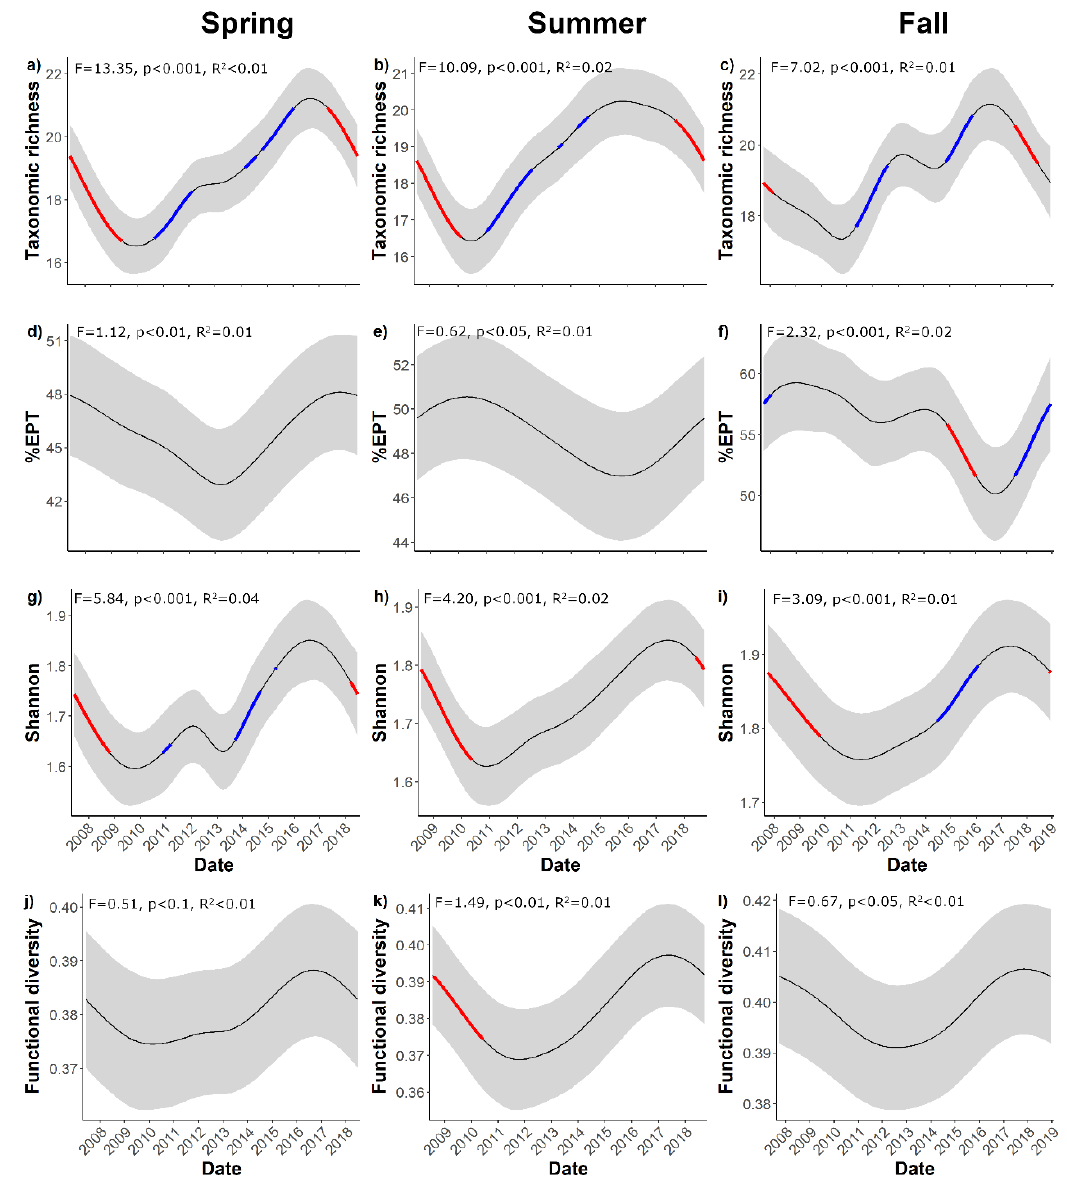
Figure 5. Temporal trajectories of ( a – c ) family richness, ( d – f ) %EPT, ( g – i ) Shannon diversity index (H’) and ( j – l ) functional diversity as a function of the generalized additive mixed-effect models (GAMMs) outputs for the different seasons. The significance of the time smoothing parameters is reported within each panel. Significant increases or decreases in slope are represented respectively in blue and red colors. Corresponding graphs, only to visualize temporal trends via LOESS (Locally Estimated Scatterplot Smoothing) for the other metrics and indices are shown in Figure S3.